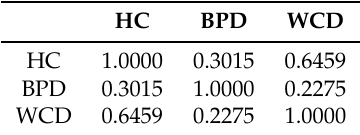
Table 9. Correlation among HC, BPD and WCD.